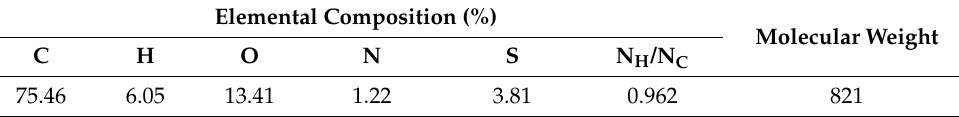
Table 5. Elemental composition of the